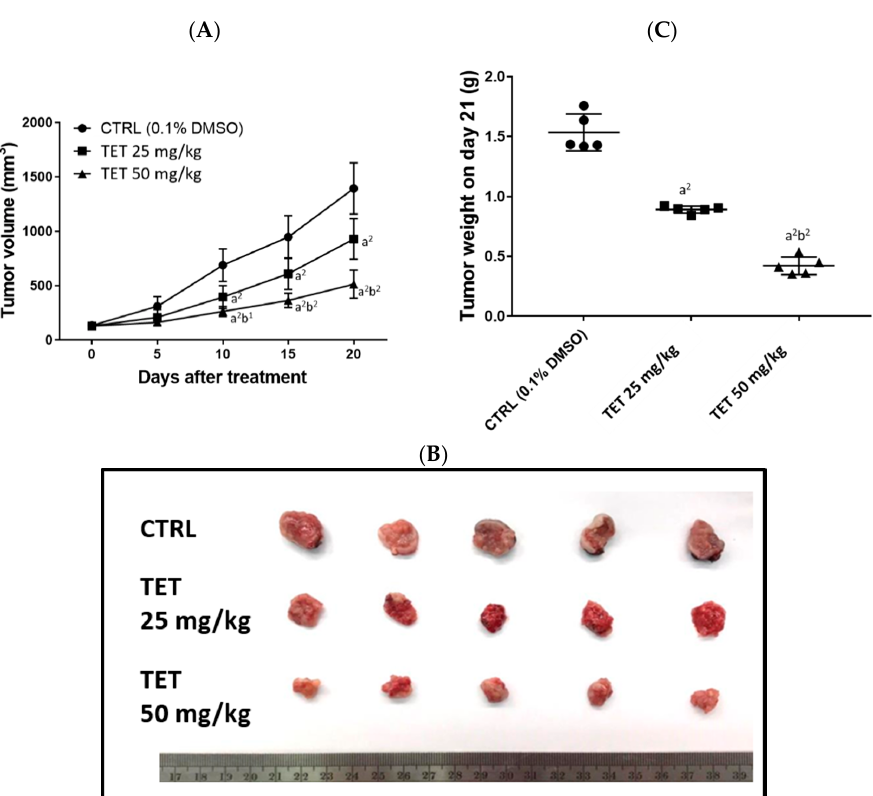
Figure 3. TET suppressed the tumor growth in GBM 8401/ luc2 -cell-xenografted animals. Tumor volume was measured by caliper every five days and quantified ( A ). Tumors from each group of mice were isolated and represented ( B ) and tumor weight was also measured and quantified ( C ) on day 21. (a 2 < 0.01 vs. control; b 1 p < 0.05 and b 2 < 0.01 vs. TET 25 mg/kg). Table 1. The accurate p -value in Figure 3A is displayed. Here we summarized the p -value between control and two treatment groups of tumor volume.